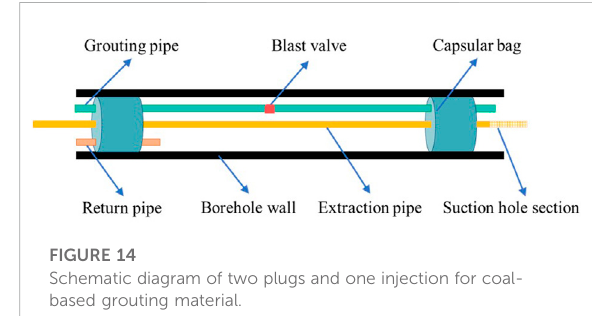
FIGURE 14 Schematic diagram of two plugs and one injection for coal- based grouting